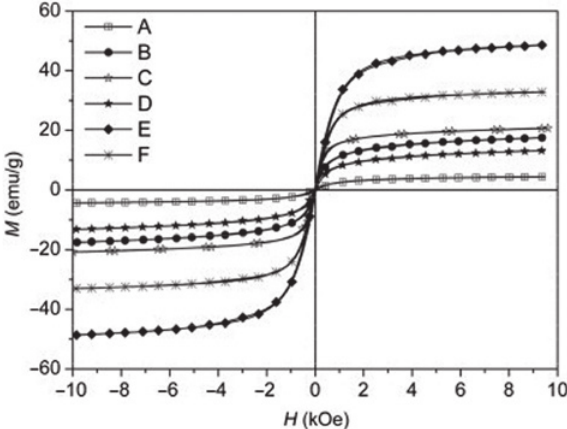
Ni alloy parti- 1− x x